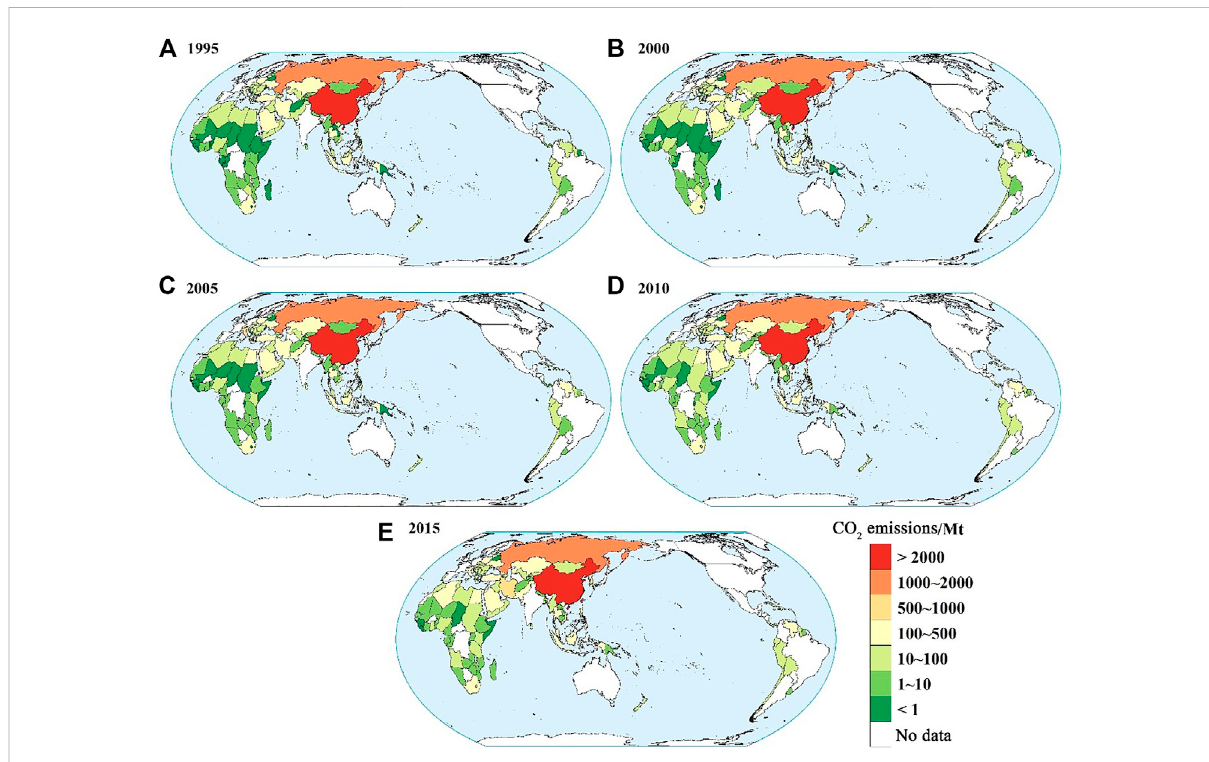
FIGURE 3 Consumption-based carbon emission distribution in the Belt and Road